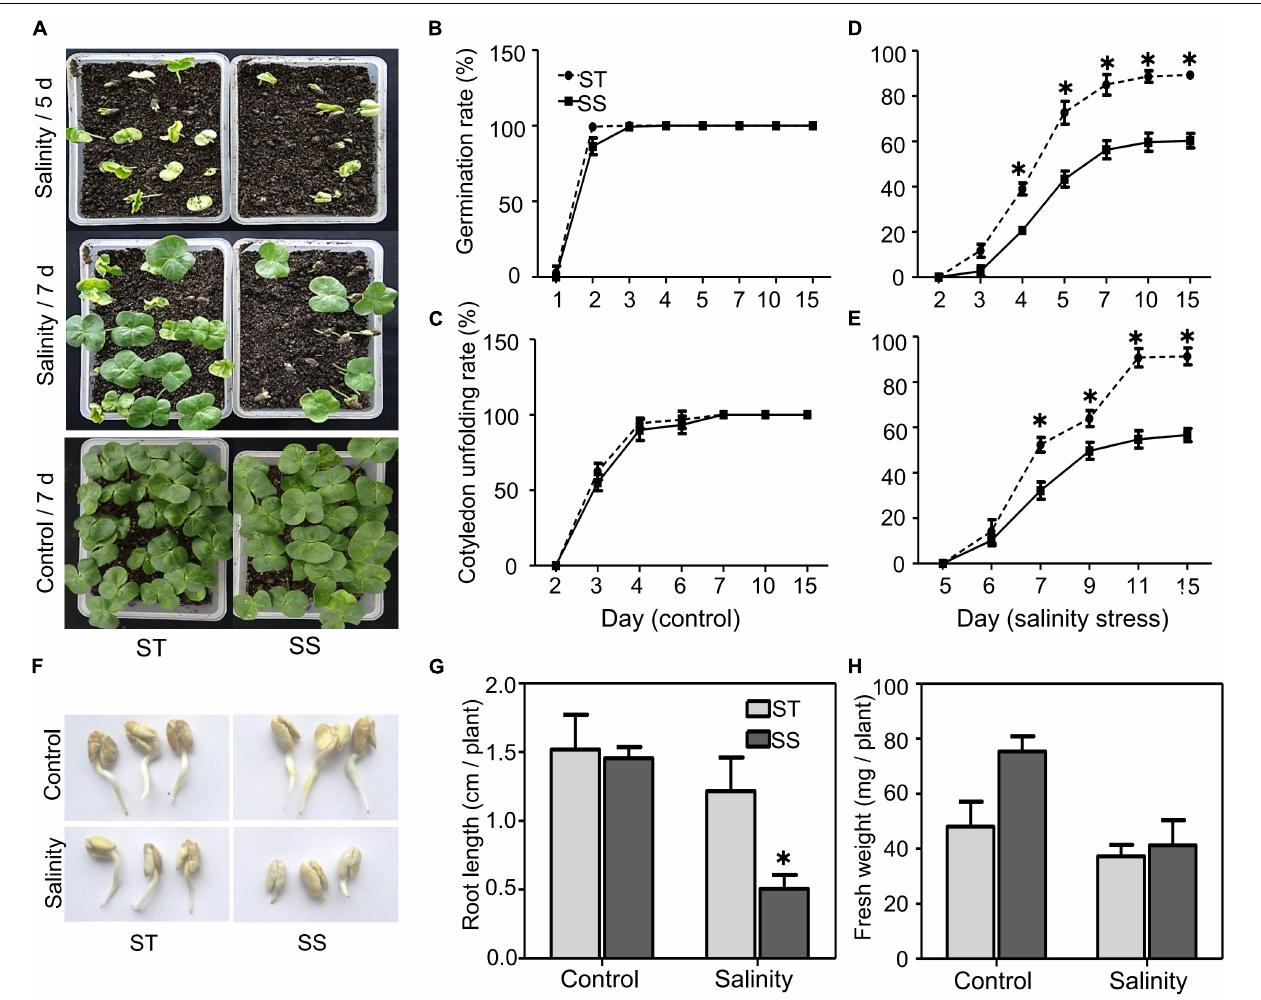
FIGURE 1 | Analysis of salinity tolerance during germination and post-germination. (A) Seed germination under control (water) or salinity stress (100 mM NaCl) conditions were analyzed at the indicated time. (B–E) Seed germination (%) and cotyledon unfolding rate (%) were analyzed. Germinated seeds were those that visibly emerged from soil. (F) Growth of primary roots under control (water) or salinity stress (100 mM NaCl) were photographed after 2 days treatment. (G) Root length and (H) fresh weight under control or salinity stress conditions (100 mM NaCl) were measured after 2 days treatment. The data are means ± SD from 25 seeds. The asterisk ( ∗ ) indicate significant differences at P < 0.05 ( t -test). All experiments were performed in triplicate.